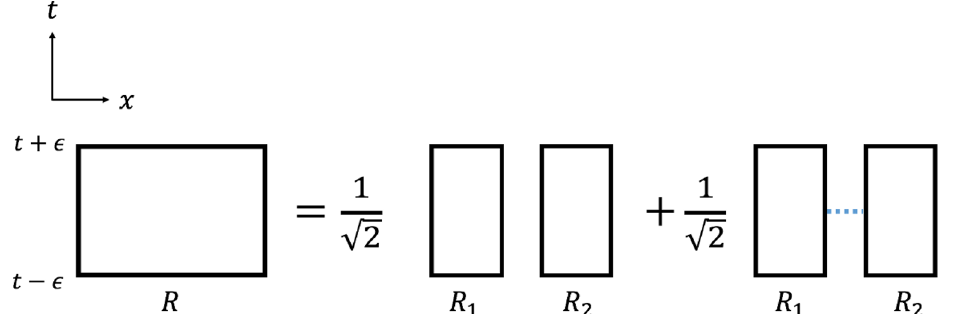
Figure 9 . The splitting of the non-invertible topological line T ( M ) (shown in black on the left) in the 2d Ising CFT, where M is the boundary of the rectangle R × [ t − (cid:15), t + (cid:15) ] . On the right-hand side of the equality, we have T ( M 1 ) and T ( M 2 ) (shown in black), as well as a Z 2 symmetry line U g joining them (shown in the dotted blue line) in the last